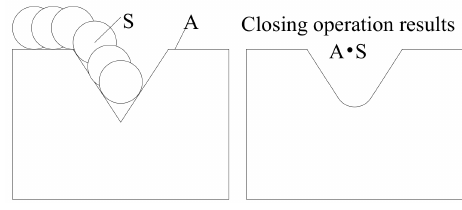
Figure 2. Closing operation schematic diagram.